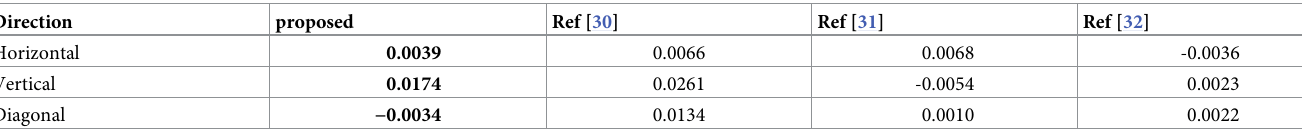
Table 4. Adjacent pixel correlation analysis of Peppers